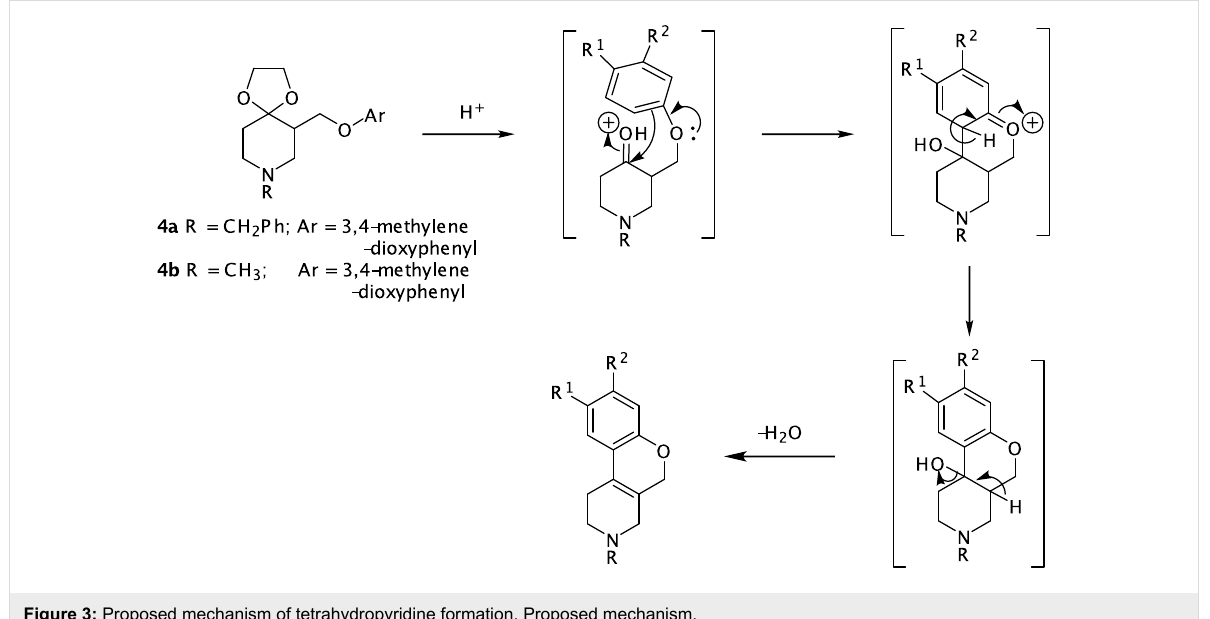
Figure 3: Proposed mechanism of tetrahydropyridine formation, Proposed mechanism.